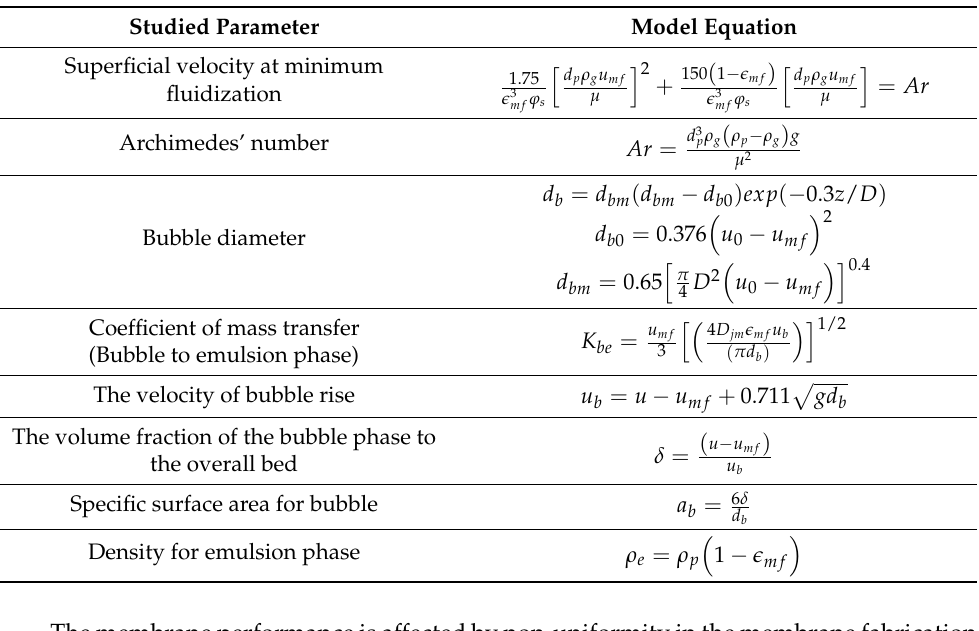
Table 2. Parameters for hydrodynamic